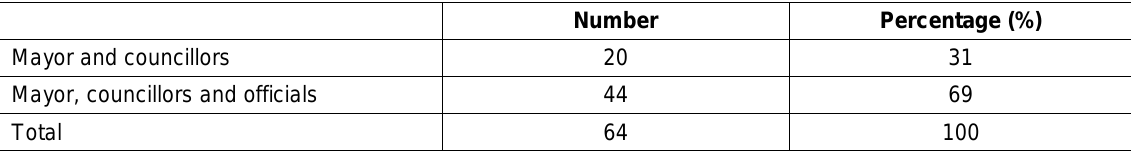
Number Percentage (%)